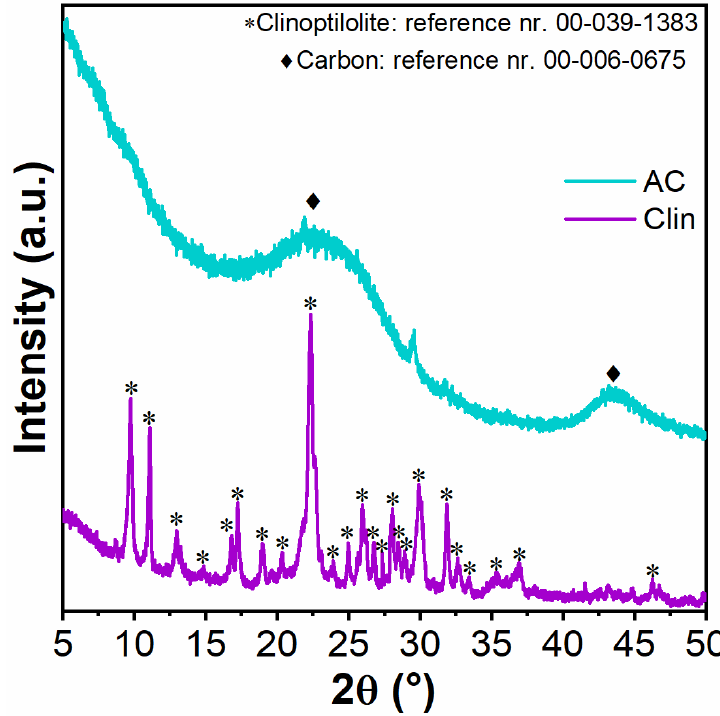
Figure 1. X-ray diffractograms in the range 5° < 2 θ < 50° over Clin and